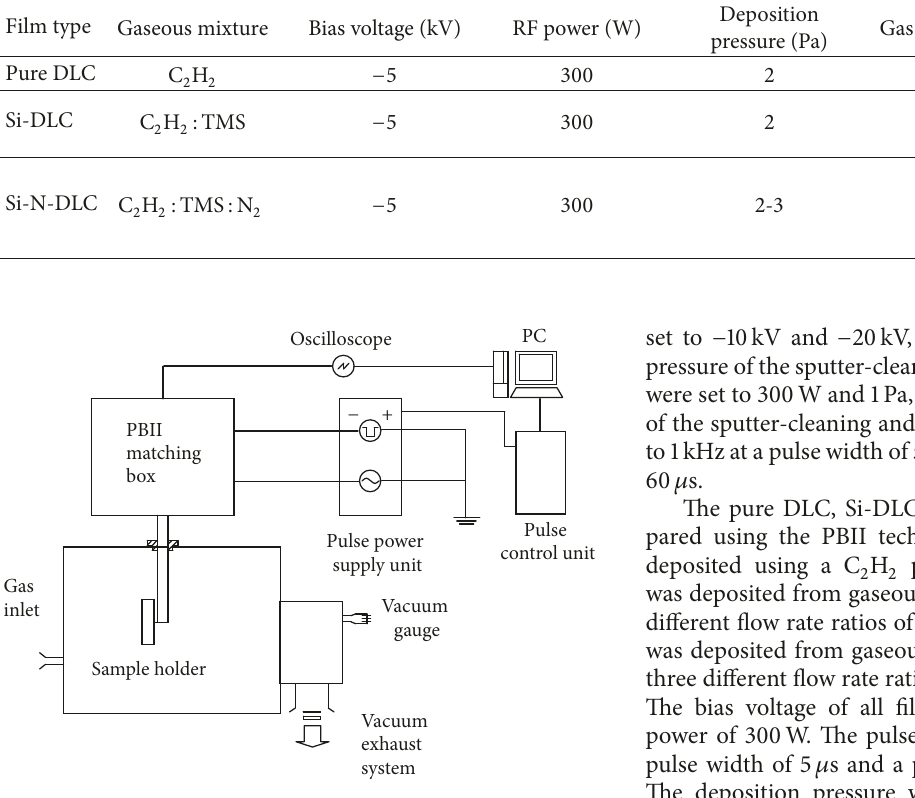
Figure 1: Schematic of the PBII apparatus used in this experiment